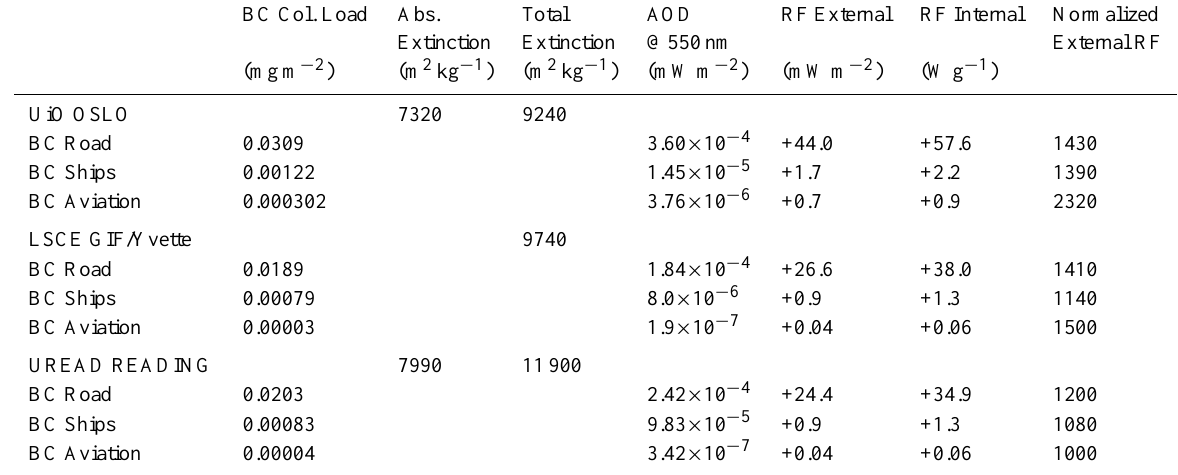
Table 3. Burden, AOD and RF for BC for the 3 MODELS. Absorption and total extinction at 550nm is given. Normalized RF is given as the all-sky radiative forcing (external mixing for all three models) divided by the burden. BC Col.